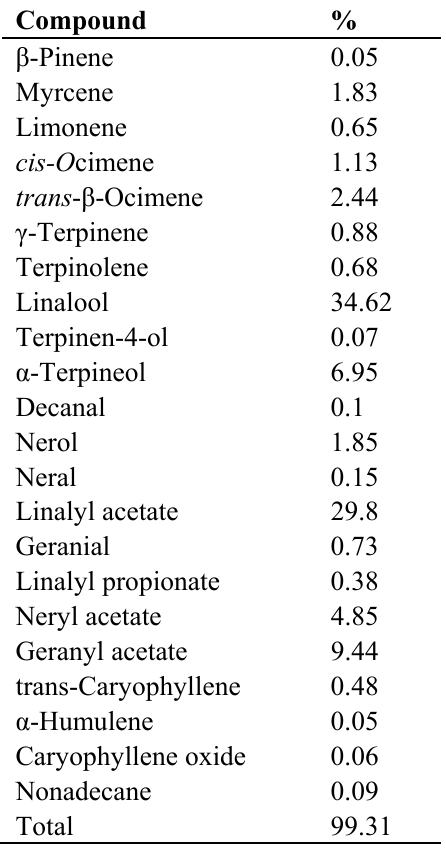
Table 2. Composition of distilled essential oil from bergamot leaves.